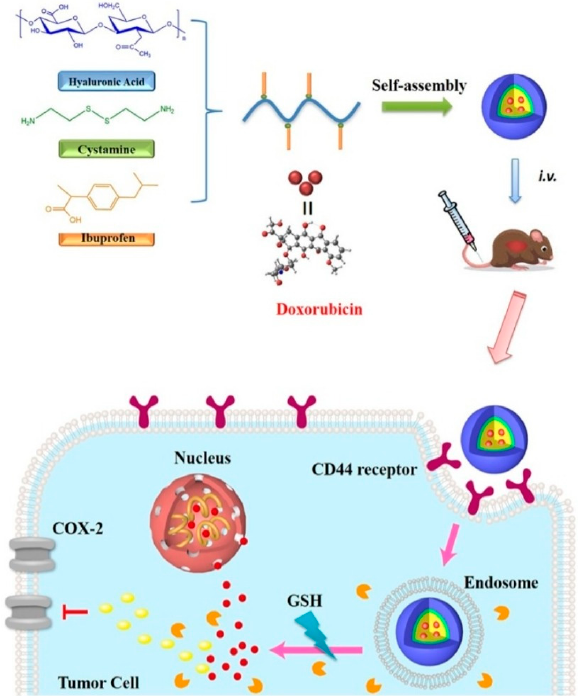
Figure 6. Schematic illustration of a polymeric micelle-based drug delivery system, HA known to target CD44 receptors through COX-2 overexpressed factor on cancer cells and DOX loaded to inhibit breast cancer cells. Reproduced with permission from ref. [118] Copyright © 2020, Elsevier. In recent advances, a study reported an effective drug delivery system befitted with enhanced targeting ability towards overexpressed CD44 receptors TNBC cells and also inhibiting metastases, causing matrix metalloproteinases (MMP) factor [119]. In Figure 7, a peculiar approach to design and synthesis was reported; in the study, hyaluronic acid D- α -tocopheryl succinate (HT) and low-molecular-weight heparin-TOS (LMWH-TOS, LT) were combined to form polymeric micelle HT-LT. Furthermore, HA affinity towards CD44 receptors was exploited to efficiently target the breast tumor site. HT-LT combined further undergo self-assembly to form spherical polymeric micelles loaded with DOX. The DOX-loaded HT-LT was further investigated for the in vitro and in vivo activity and bio- compatibility studies. HT-LT-loaded DOX was found to be effective and less toxic to- wards breast cancer cell lines and 4T1 mouse model, in in vitro and in vivo studies, re- spectively. For metastatic-breast-cancer-infested mice, the drug carrier of HT-LT loaded with DOX showed effective inhibition of cancer and further inhibited metastases by MMP factors. However, clinical evaluations and verifications are awaited. Recent examples of micelle-based drug delivery systems for breast cancer therapy have been gathered in Ta- ble 3.